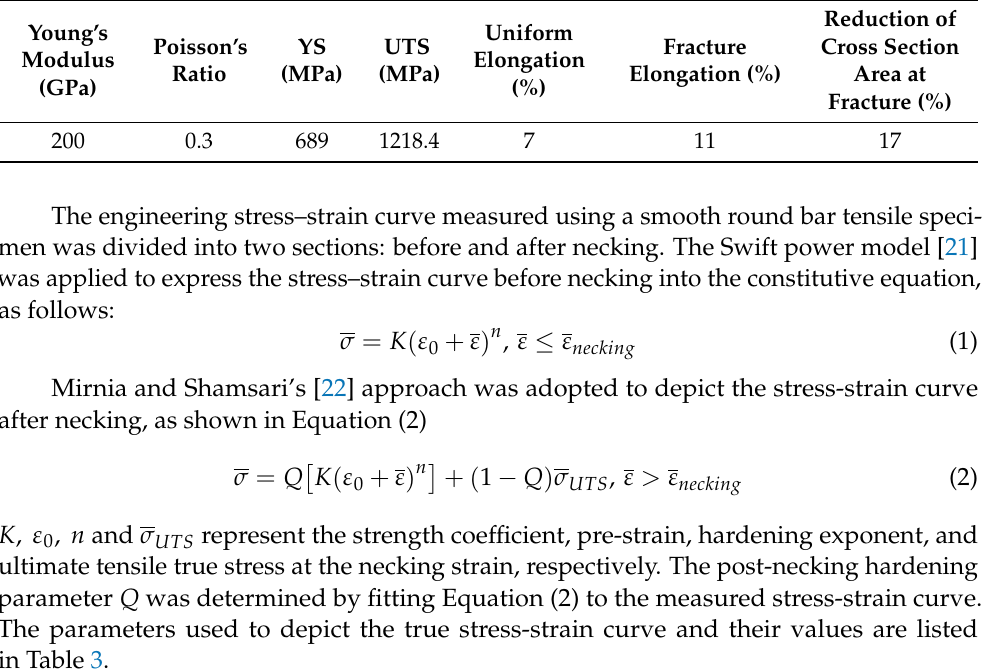
Table 3. Parameters used in expressing the true stress–strain curve and their values. K